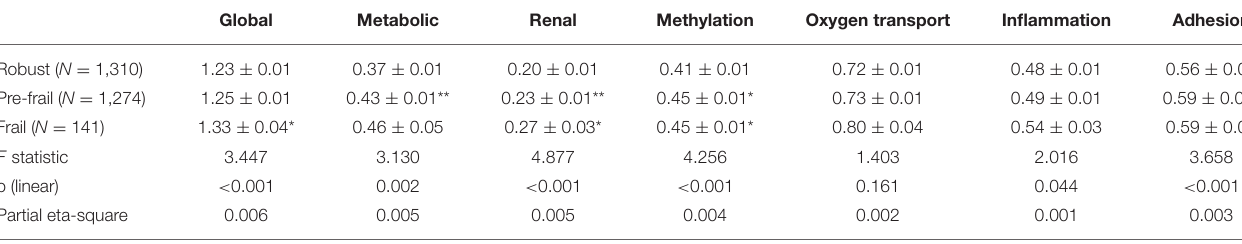
TABLE 2 | Baseline associations of global and system-specific PD with physical frailty ( N = 2,906).